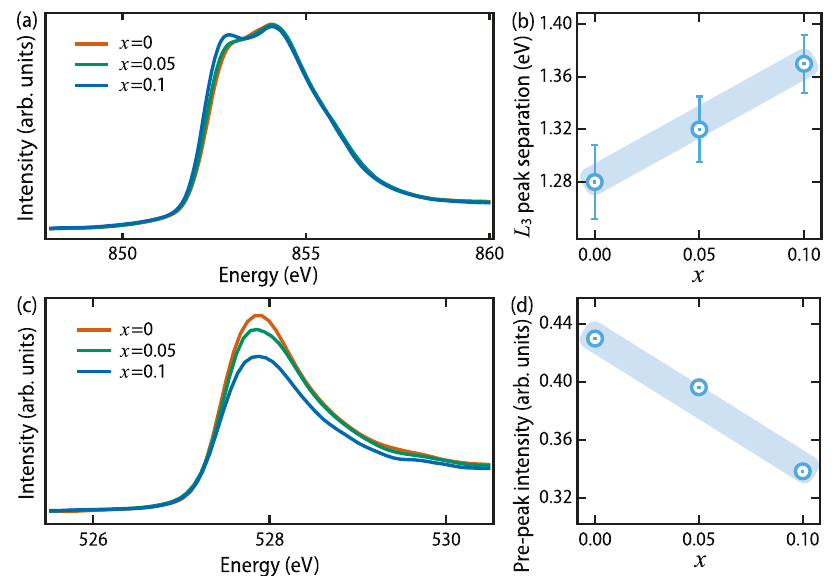
Fig. 3 X-ray absorption spectroscopy. a Normalized X-ray absorbtion spectra at Ni L 3 -edge. b The energy separation between the two peaks of the L 3 -edge for x = 0, 0.05, and 0.1 thin fi lms. The error bar is de fi ned from the errors in the peak position while fi tting the two peaks of the Ni L 3 -edge. c O K -edge XAS pre-peak and d the pre-peak intensity as a function of Ca doping. The shaded regions in b and d are guide to the